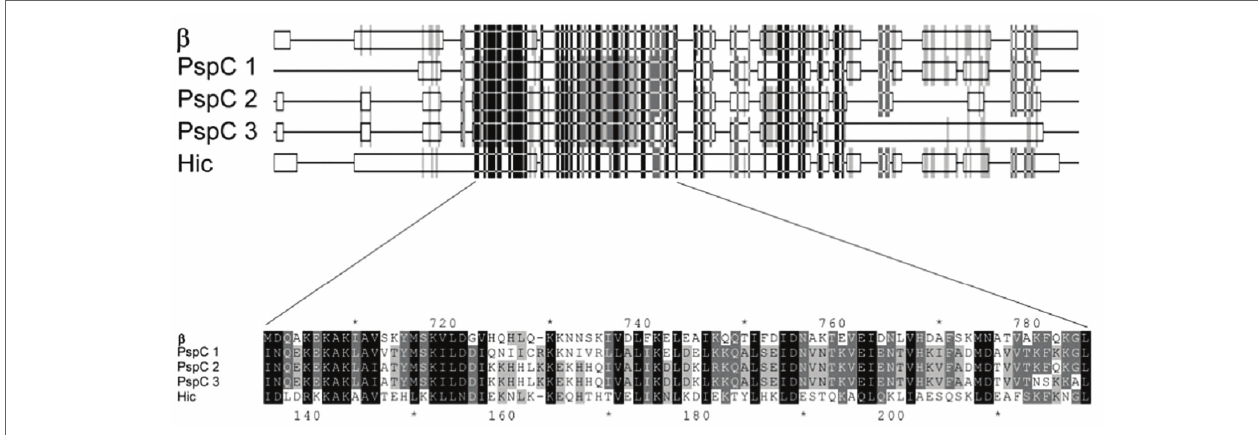
FIGURE 1 | Part of the alignment of the amino acid sequences of β , three pneumococcal surface protein C (PspC) proteins, and Hic (Adapted from Jarva et al.,